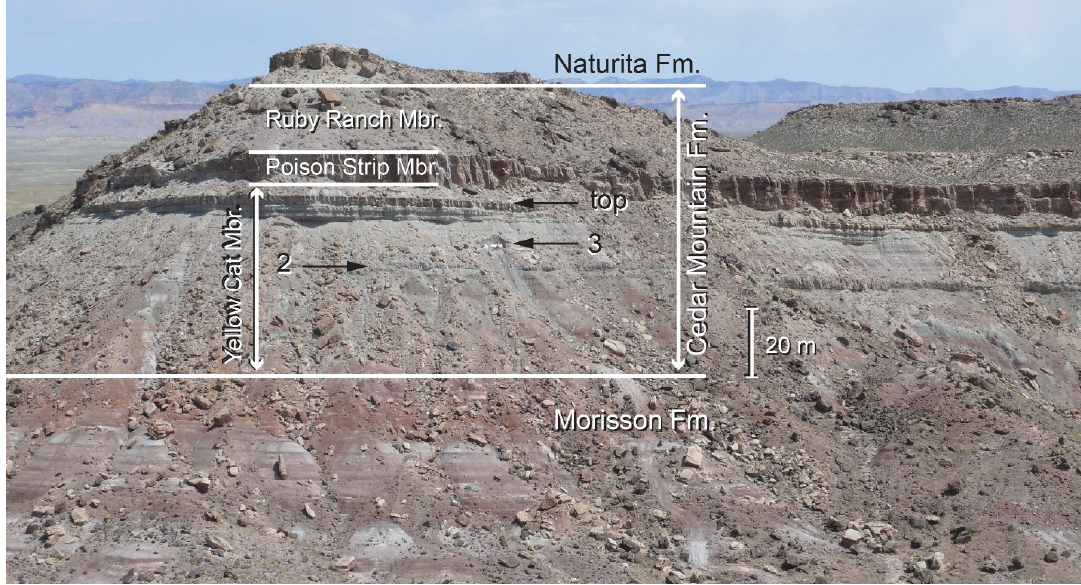
Figure 3. West end of Utahraptor Ridge, Utah, looking north; photograph taken approximately parallel to strike. Stratigraphic levels 2 and 3 are also identified in Figure 2. Stratigraphic level identified as “top” is the top of the stratigraphic section in Figure 2.